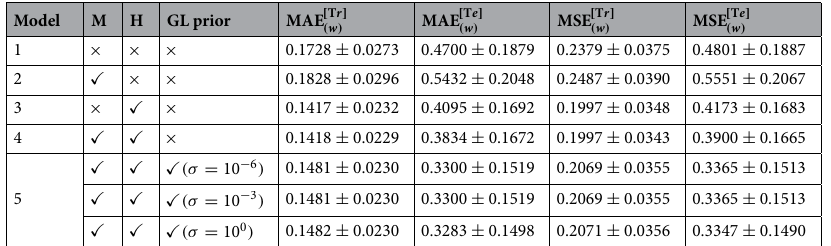
[ T r ] [ T e ] ( w ) , MAE ( w ) ,